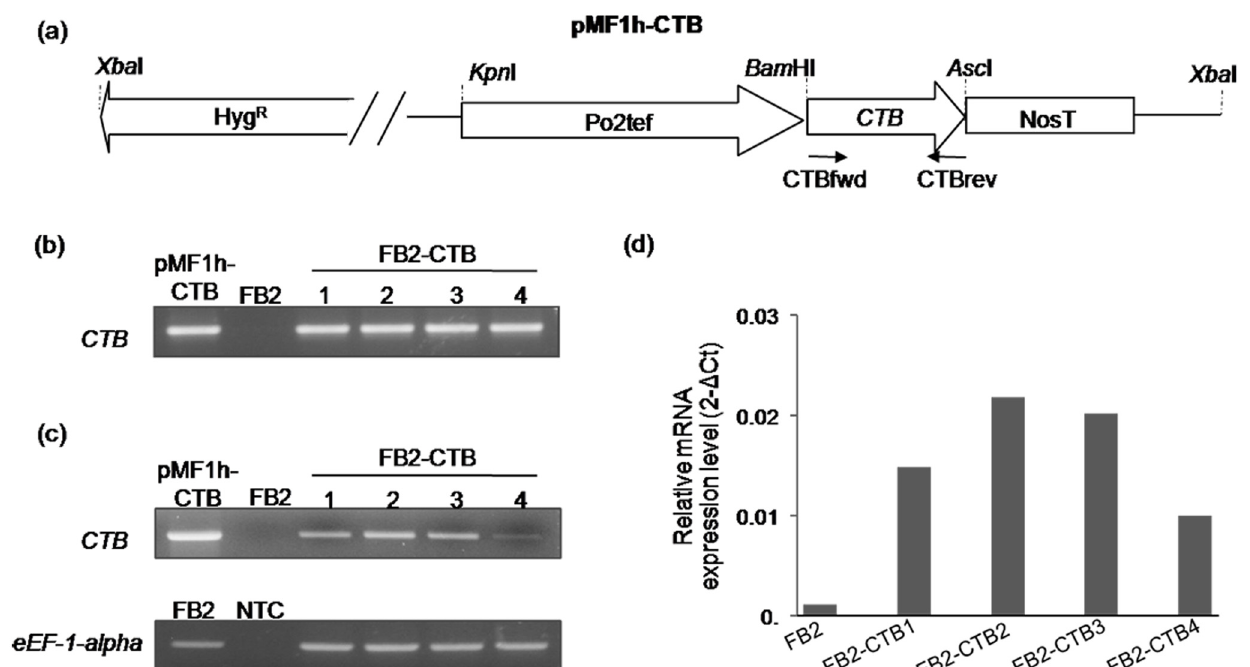
Fig 1. Expression of the Vibrio cholerae CTB gene in the yeast-like U . maydis FB2 strain. (a) Schematic diagram of the pMF1h-CTB plasmid used for transformation of U . maydis FB2. The CTB gene was fused to the constitutive Po2tef promoter and to the nopaline synthase terminator (NosT). (b) Specific amplification of the CTB gene from the genomic DNA of four FB2-CTB transformants, using the CTBfwd and CTBrev primers. (c) and (d) Expression of the CTB gene in four FB2-CTB transformants determined by semi-quantitative RT-PCR and quantitative RT-PCR expression, respectively. Quantitation of the CTB gene expressed as relative mRNA expression levels (2 - Δ Ct ), was calculated after normalization to the U . maydis eEF-1-alpha gene, used as control. Total RNA was isolated from WT and CTB -expressing FB2 yeast-like cells grown in YPD medium in agitation at 28°C, during 12 h. Genomic DNA from U . maydis FB2 strain, the plasmid pMF1h-CTB, and a sample without template (NTC), were used as